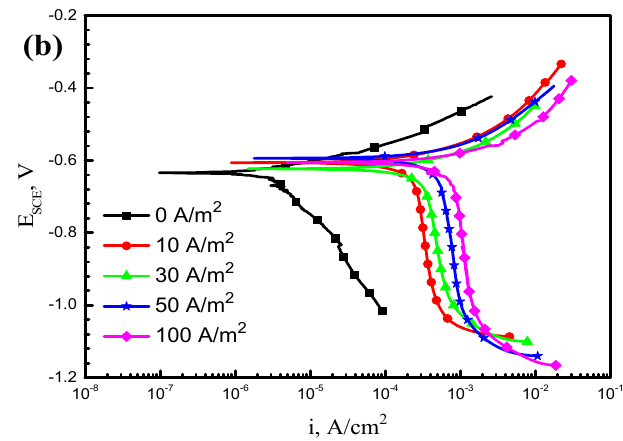
Figure 4. Polarization curves of the X70 steel tested at various AC densities in simulated seawater: ( a ) non-stress samples and ( b ) U-bend samples.